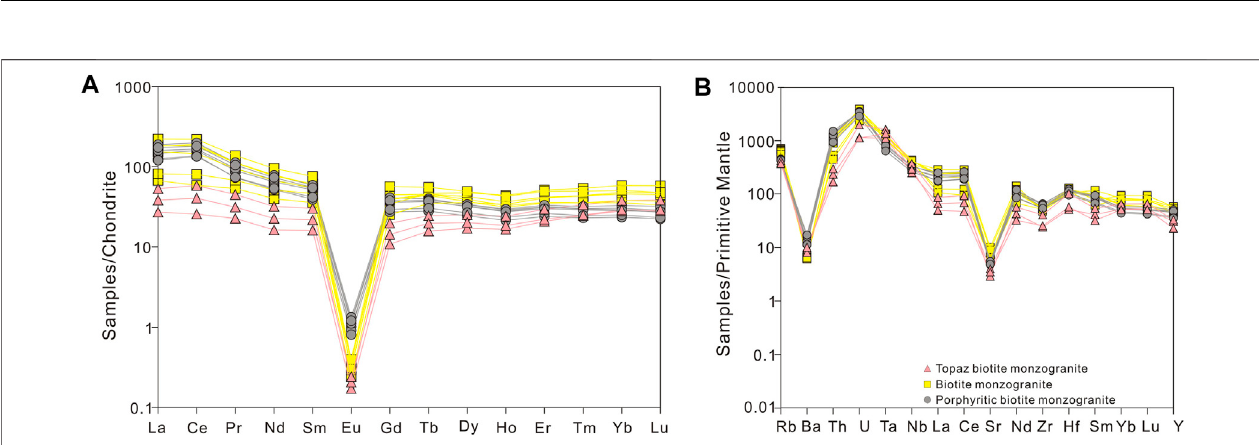
FIGURE 6 | (A) Chondrite-normalized REE patterns and (B) primitive mantle-normalized trace element for the Jianfengling pluton. Primitive-mantle and chondrite normalizing values are from Sun and McDonough (1989) and Taylor and McLennan (1985), respectively.